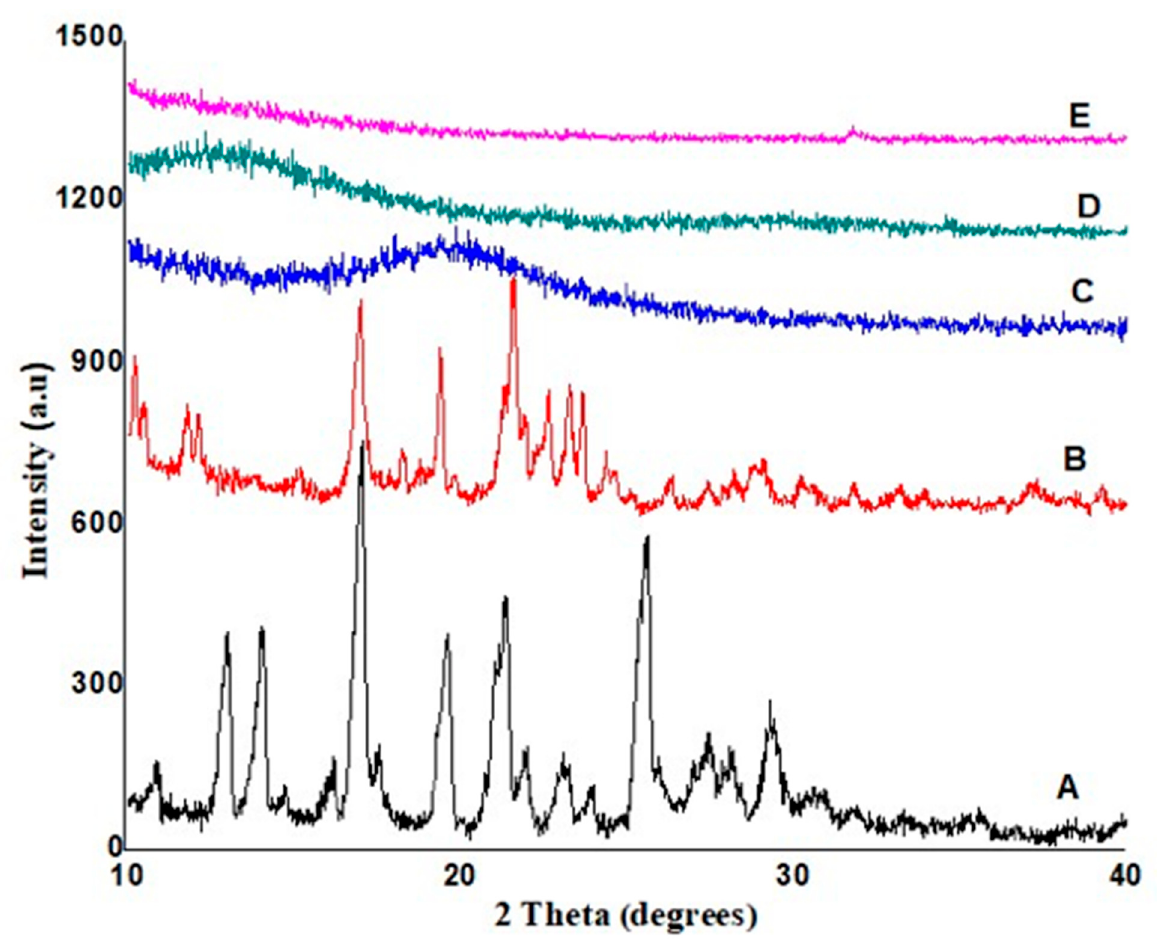
Figure 3. XRD of atorvastatin (A), ezetimibe (B), HPMC K-100 (C) formulation F1 (D) and F2 (E).